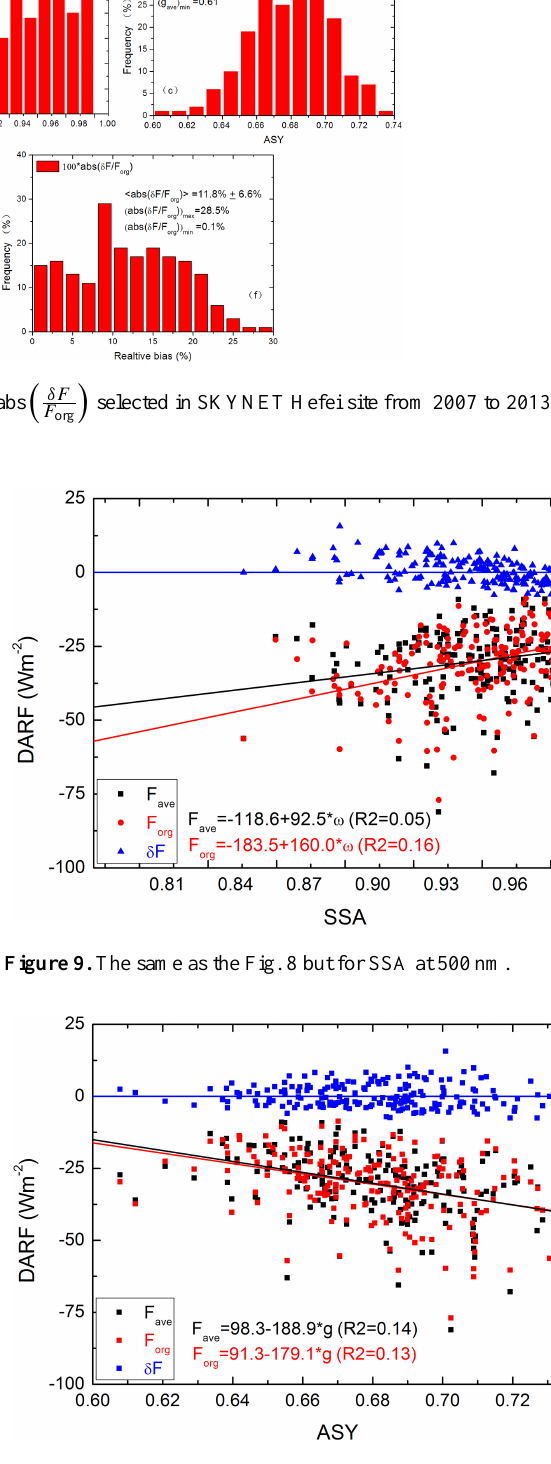
Figure 10. The same as the Fig. 8 but for ASY at